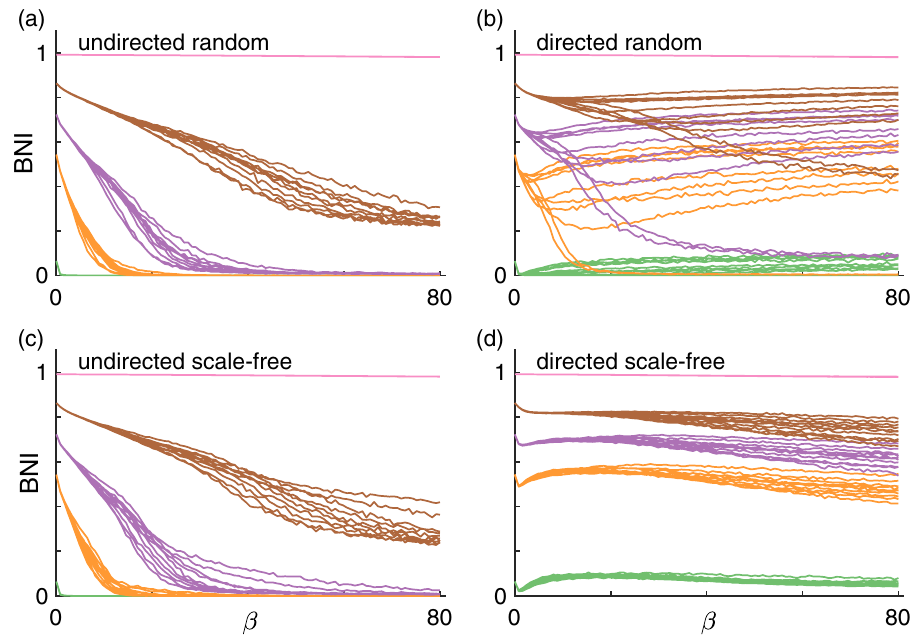
Figure 5. BNI as a function of diffusive coupling strength β . Each color corresponds to a different level of noise α : green is α = 0.01 , orange is α = 0.03 , purple is α = 0.05 , brown is α = 0.1 , and pink is α = 1 . All other parameters are the same as in Fig. 4.